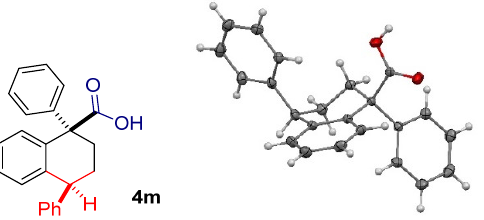
Figure 5. Structure of 4m and its ORTEP diagram showing 30% probability ellipsoids.